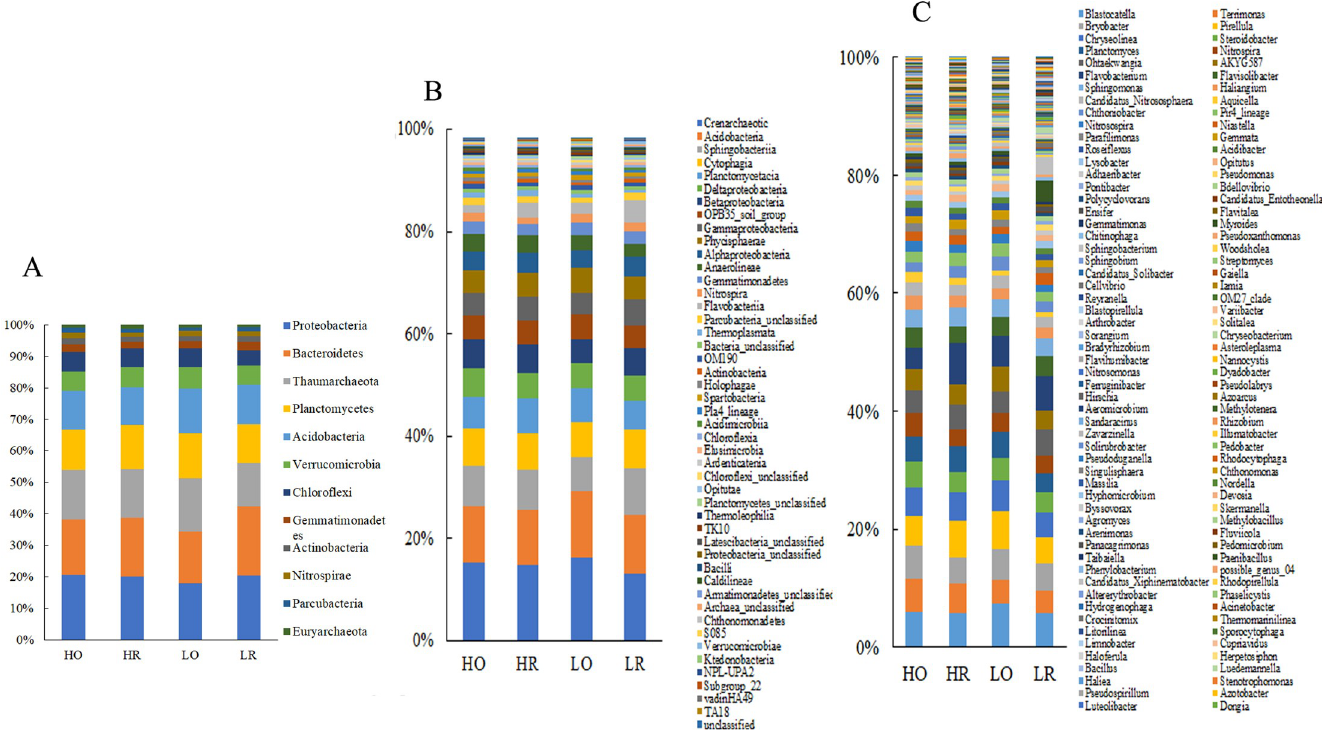
Fig 2. Relative average abundances of the most abundant taxa across soil groups. A. Phyla (relative abundance > 1%), B. Classes (relative abundance > 0.1%), C. Genera (relative abundance > 0.01%).